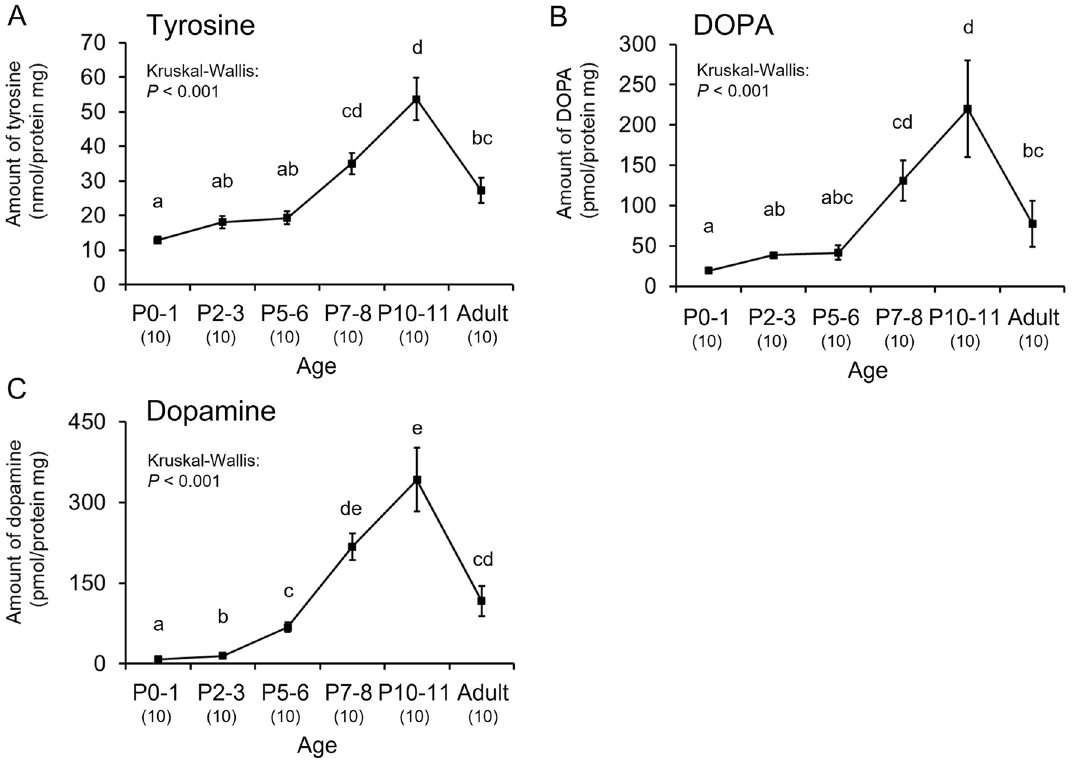
Figure 7. Age-dependent changes in dopamine-related substances normalized by brain protein in honey bee drones during the pupal stage. Changes in tyrosine levels ( A ), DOPA levels ( B ), and dopamine levels ( C ) are shown. Error bars indicate standard errors. Significant differences according to the Steel–Dwass test ( P < 0.05) are indicated by different letters. Sample sizes are shown in parentheses below the age.